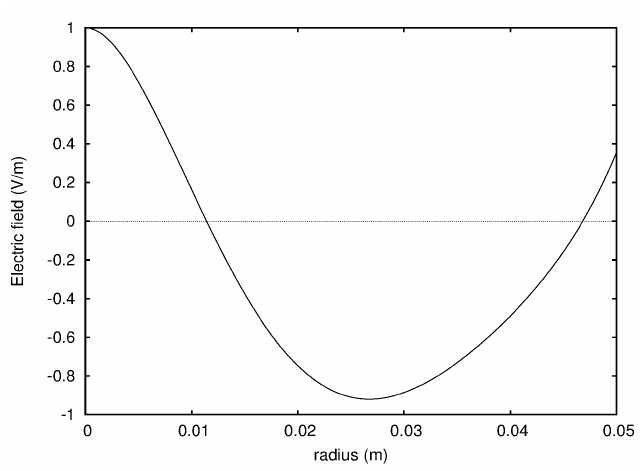
Figure 6. A particular solution with analytical analysis of the electric field inside a cylindrical wood sample when the corrective factor for the effective relative permittivity is 0.66 and the grain angle is α = 30°.